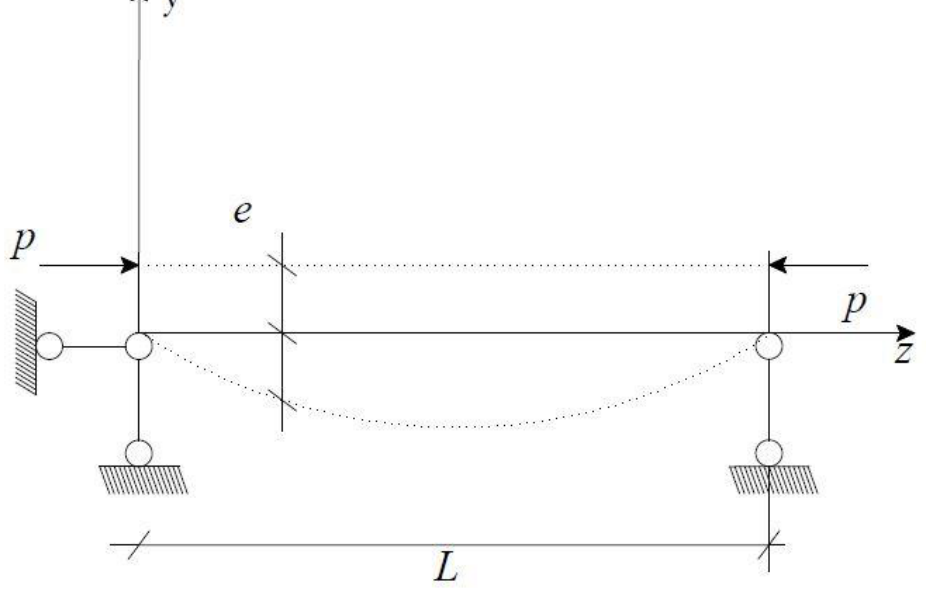
Figure 8. Mechanical model of a cylindrical shell subjected to eccentric compression. For a circular section, λ is defined as the centre angle corresponding to the half length of the crack. So, the crack length is determined by changing the central angle λ . The value range of λ is 0 ◦ –45 ◦ , and the corresponding crack length b = R · λ . Here, the total crack length is determined as 2 a ∈ ( 0, 2 b ) . The ratio of the crack length to its maximum crack length is ξ 1 = a / b , which is called as the crack length coefficient, and the value range is ξ 1 ∈ ( 0.1, 1.0 )